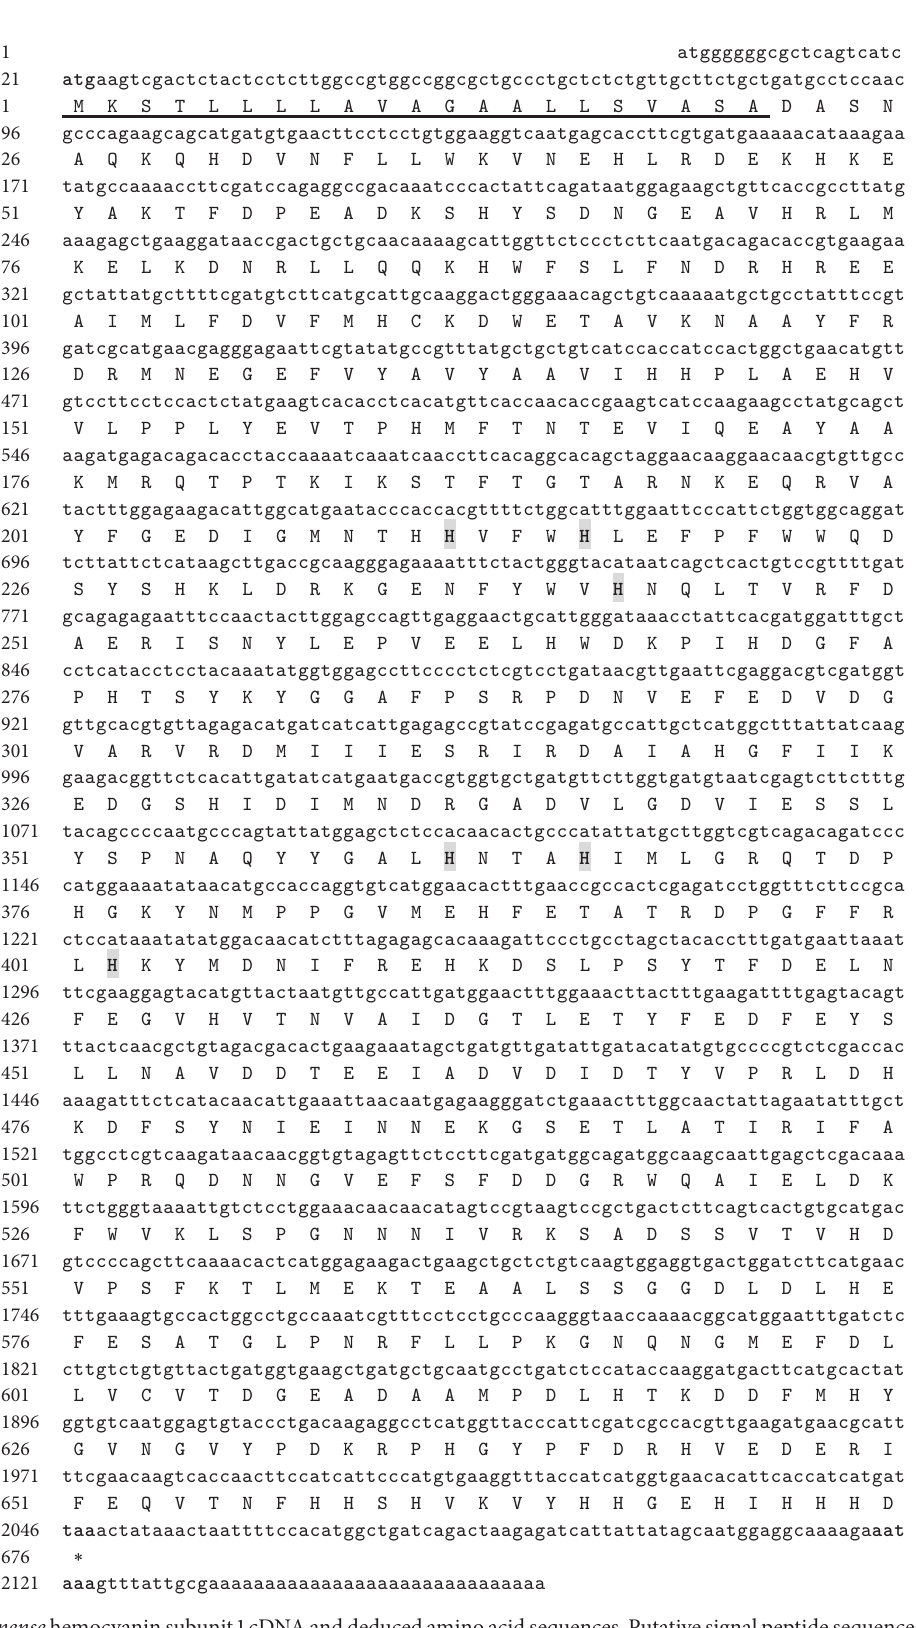
Figure 1: M. nipponense hemocyanin subunit 1 cDNA and deduced amino acid sequences. Putative signal peptide sequences were underlined. The start codon (atg), stop codon (taa), and the polyadenylation signal sequence (aataaa) were marked in bold and the six histidine residues within the copper-binding sites were marked in bold and shadow